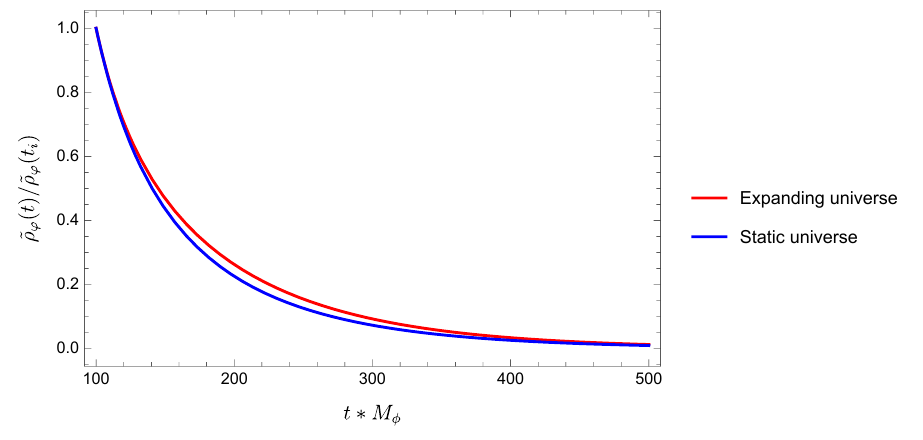
Figure 7 . Evolution of the (comoving) energy density of the condensate. The energy density of the condensate in a static universe, i.e., eq. (3.31), is drawn in the blue line and the comoving energy density of the condensate in a radiation-dominated universe, i.e., a 3 times eq. (3.51), is drawn in the red line.